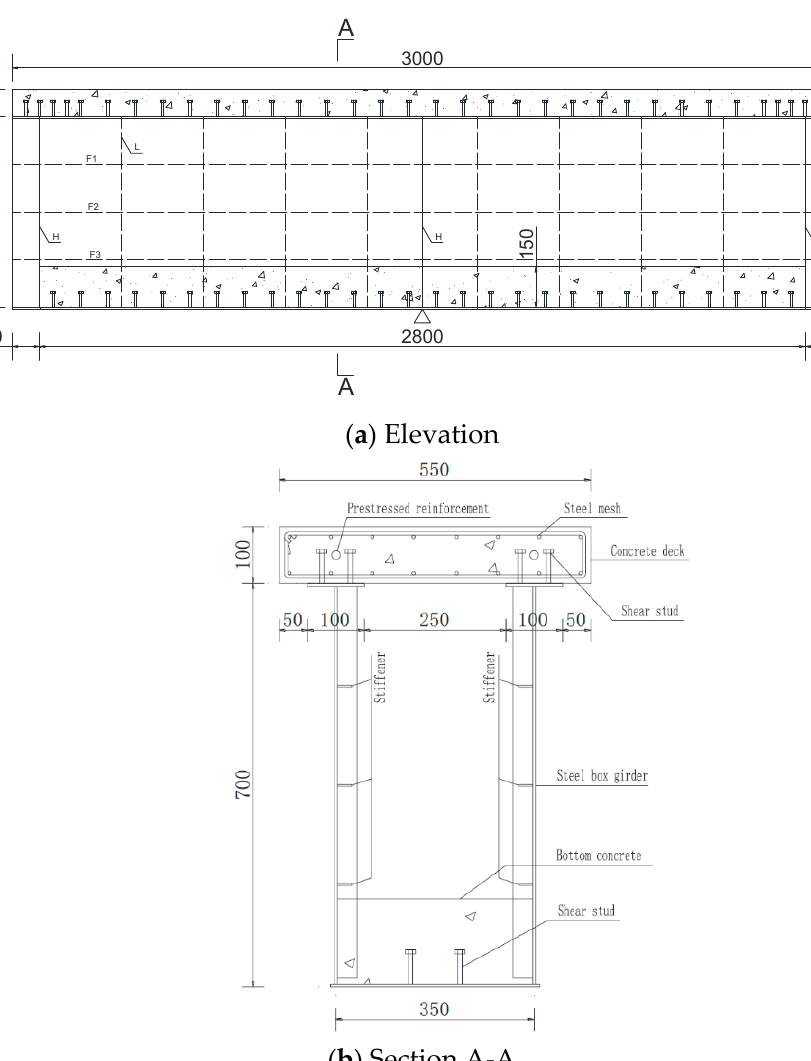
Figure 2. Structure diagram of the experimental beam (Unit: mm).